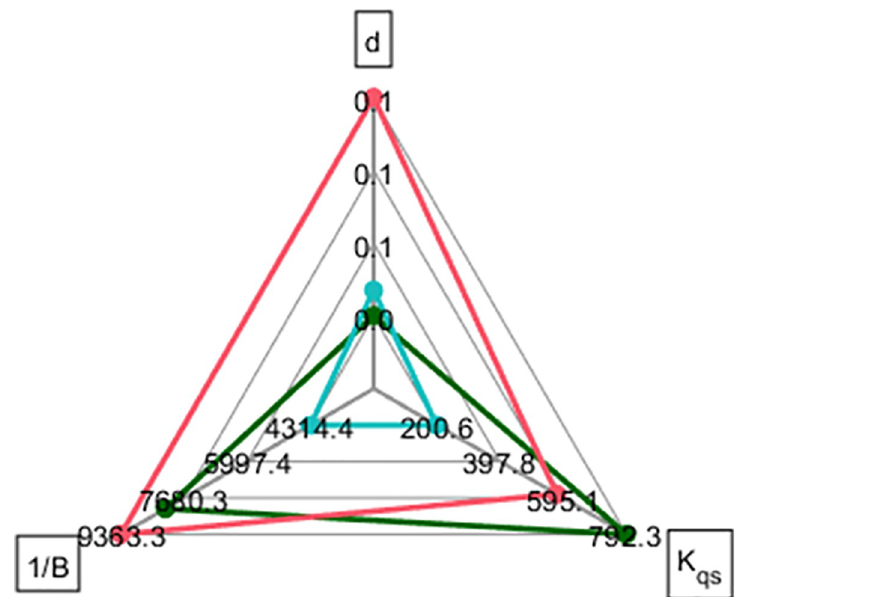
Fig 6. Spider plot for representative strains. Giraffe 32 (red), Lion 58 (green) Leopard 31 (cyan).